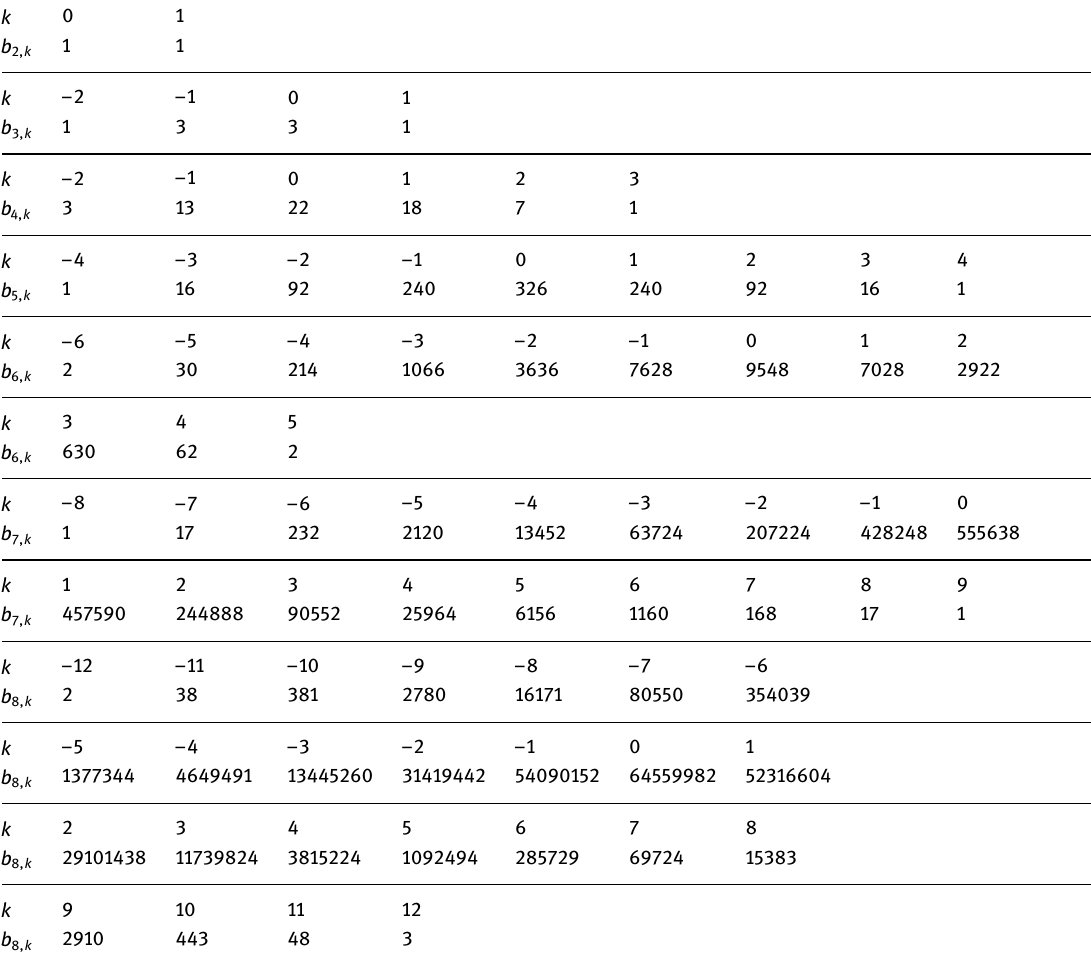
Table 4: The values of b n k , for ⩽ ⩽ n